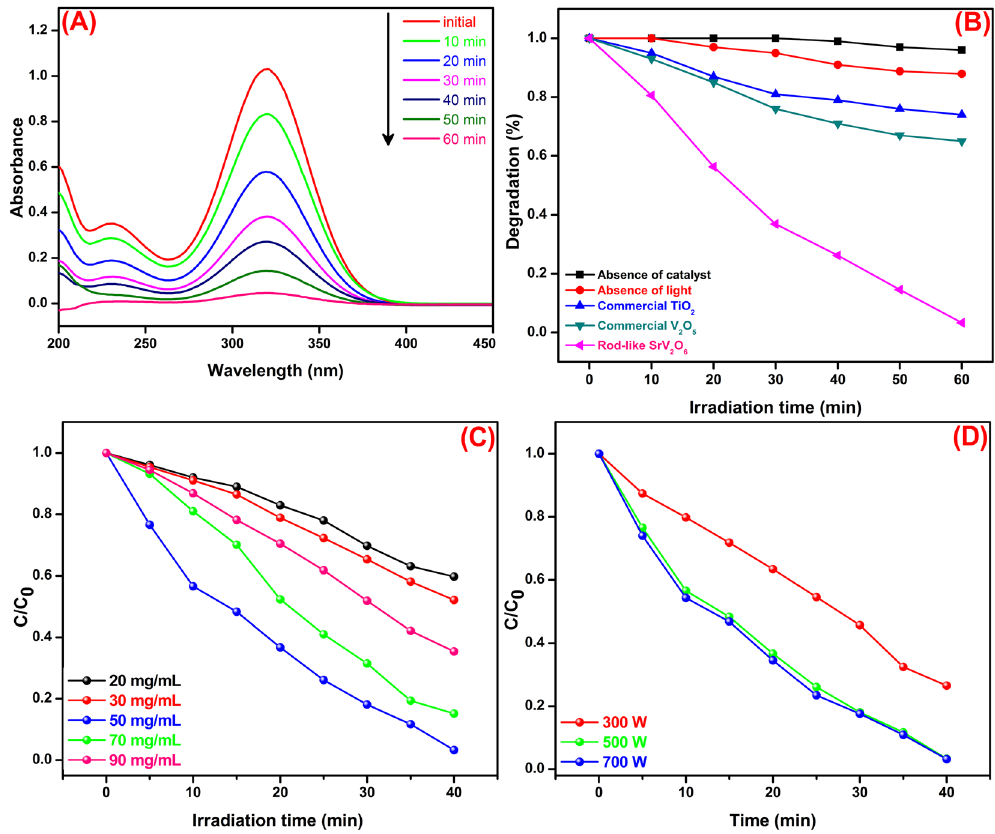
Figure 9. Time-dependent absorption spectrum of MNZ photodegradation ( A ), Effect of different catalyst dosage ( B ), Effect of catalyst dosage and ( C ) Effect of light intensity on the photodegradation of MNZ ( D